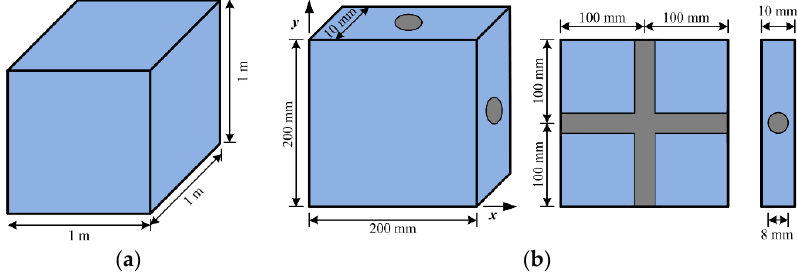
Figure 9. Representative volume elements for local finite element test; ( a ) Concrete representative volume element (RVE); ( b ) RC RVE. Table 3. Configuration of the local test. RVE: representative volume element.